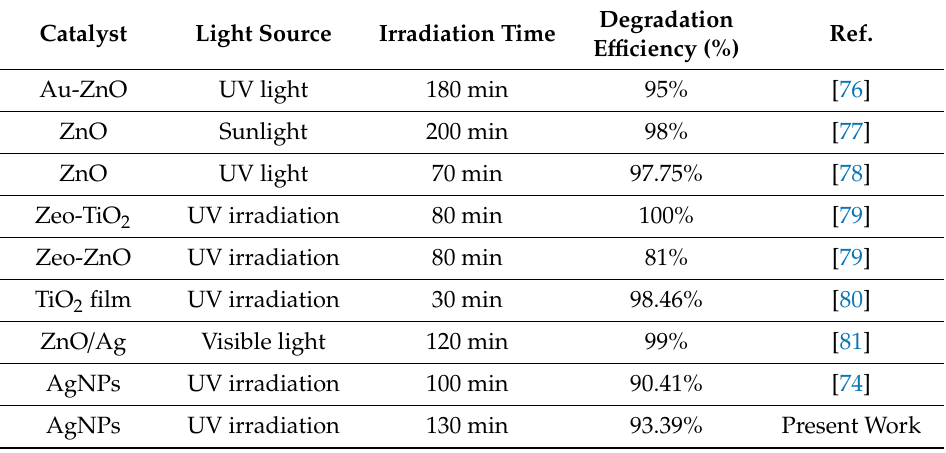
Table 3. Comparative study of the photocatalytic e ffi ciencies of the di ff erent